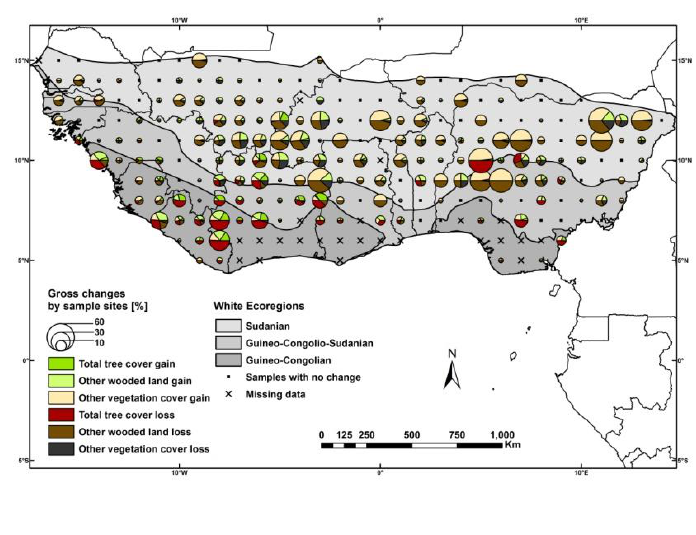
Figure 10. Overall gross land cover change estimates over 1975–1990 by sample site over the West Africa. Changes are expressed by percentage of the changed area compared to total sample site area (pie chart size) and by proportion for each land cover class (pie chart